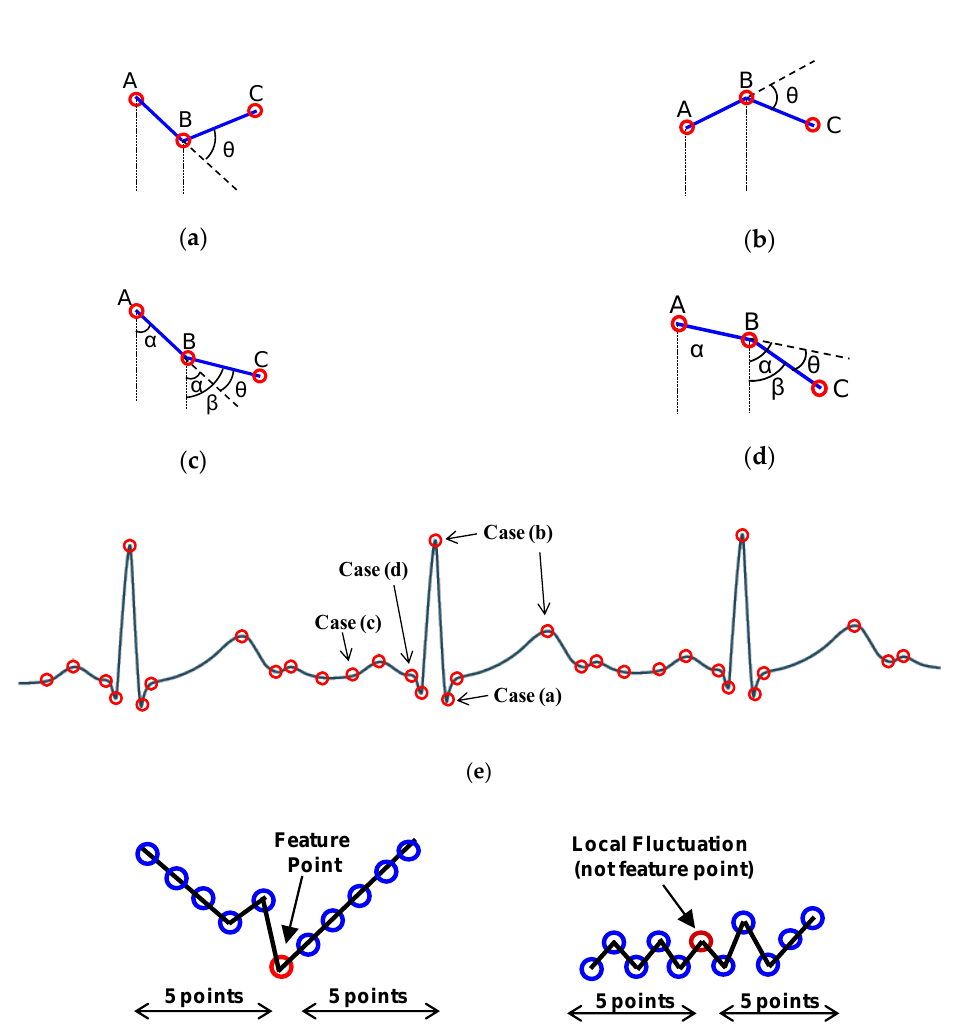
Figure 4. Four cases in turning angle detection. ( a ) Case I; ( b ) Case II; ( c ) Case III; ( d ) Case IV; ( e ) the four cases in an ECG signal example; ( f ) detection window check.